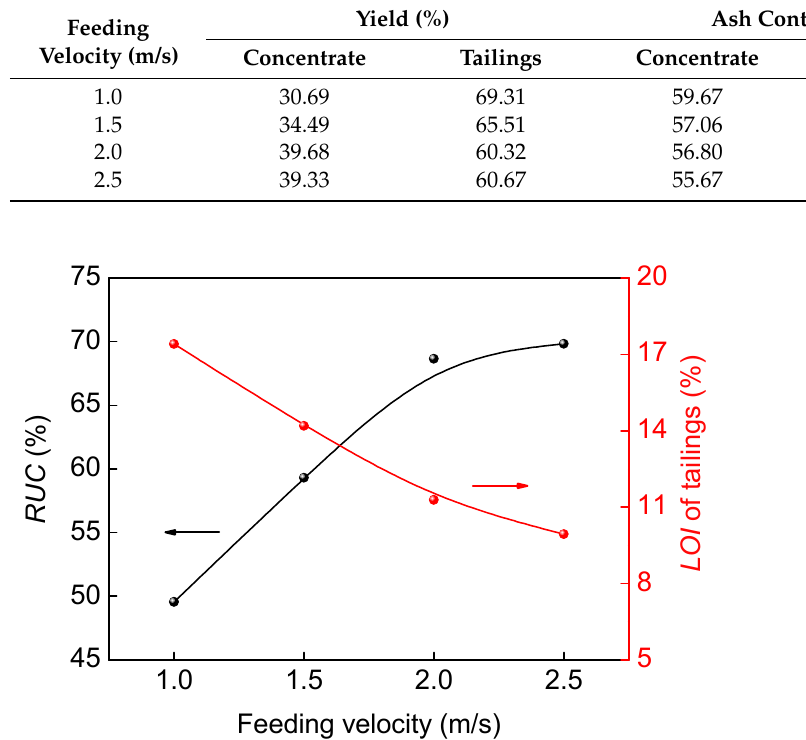
Figure 12. Flotation results after pulp conditioning for different feeding velocities.